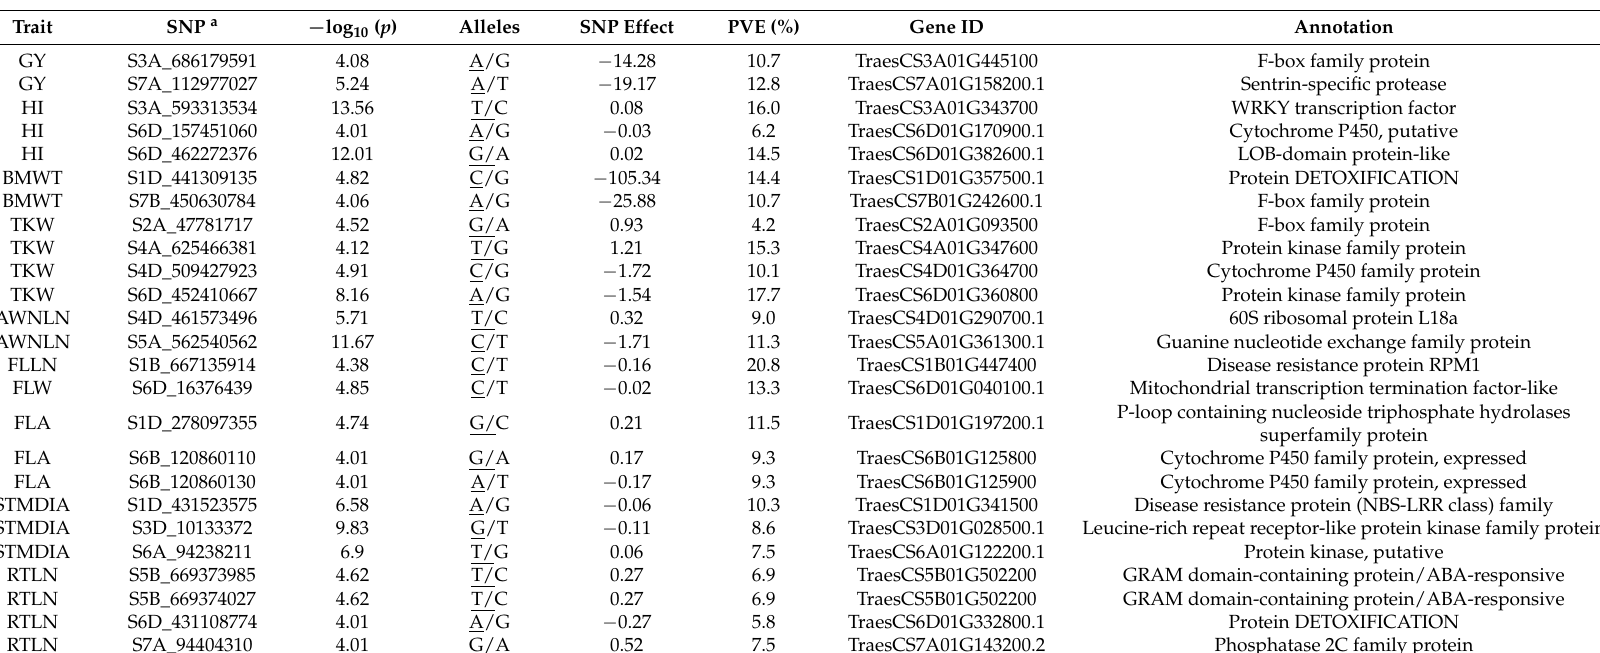
Table 3. List of significant markers associated with GY and yield-related traits, favorable alleles (underlined), SNP effects, and drought-related putative genes from genome-wide association study of 123 drought stressed synthetic hexaploid wheats grown in 2016 in Konya,